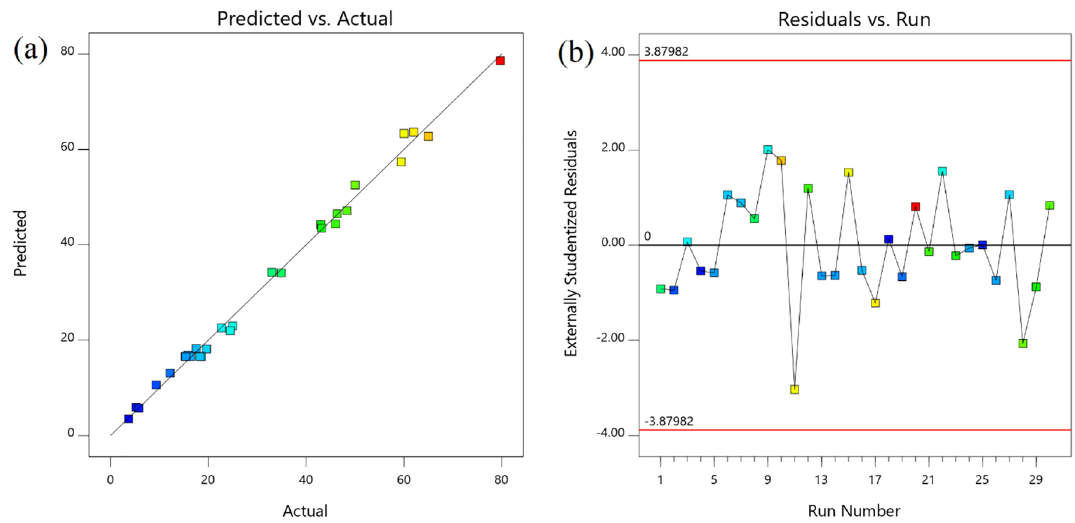
Figure 7. Predicted vs. actual ( a ) and residual vs run ( b